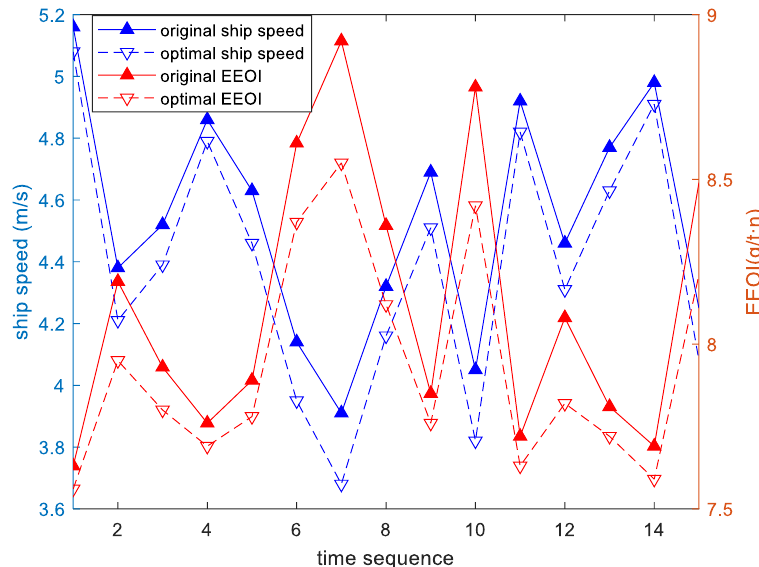
Figure 9. Real-time optimization results of ship energy efficiency.